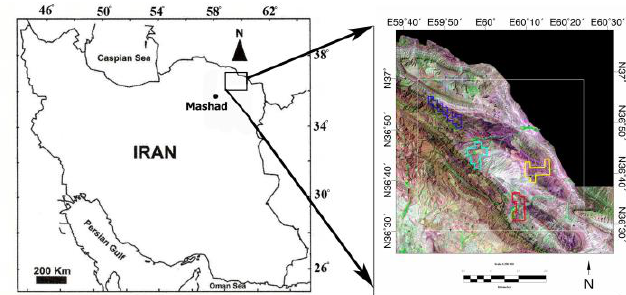
Figure 1. Locations of the four study area. Abgarm polygon is in Red colour in the below of 3 other area ( Hamam Gale in dark blue, Zavin in cyan and Sangane in yellow) in the Landsat image (right